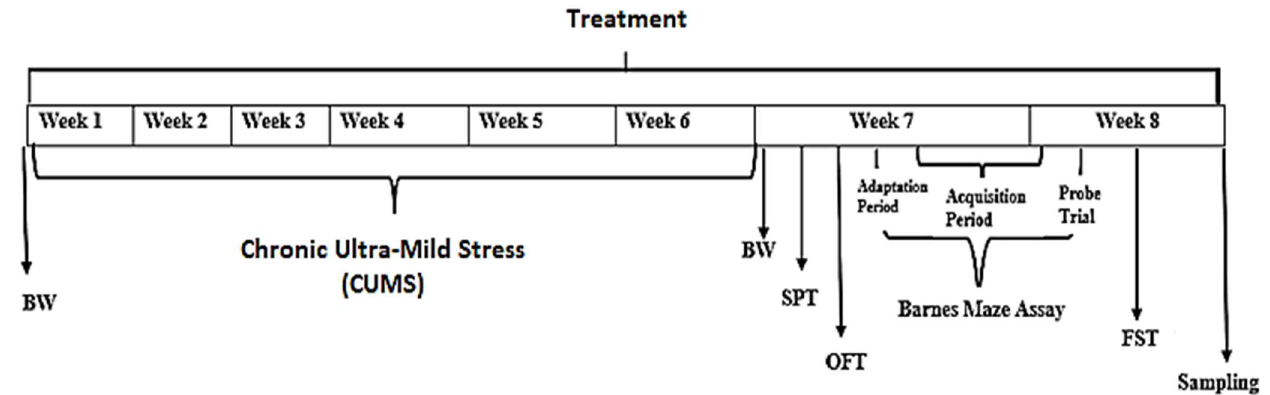
Figure 1. Schematic experimental design. BW means measurement of body weight, SPT means Sucrose preference test, OFT means Open field test and FST stands for Forced swimming test.